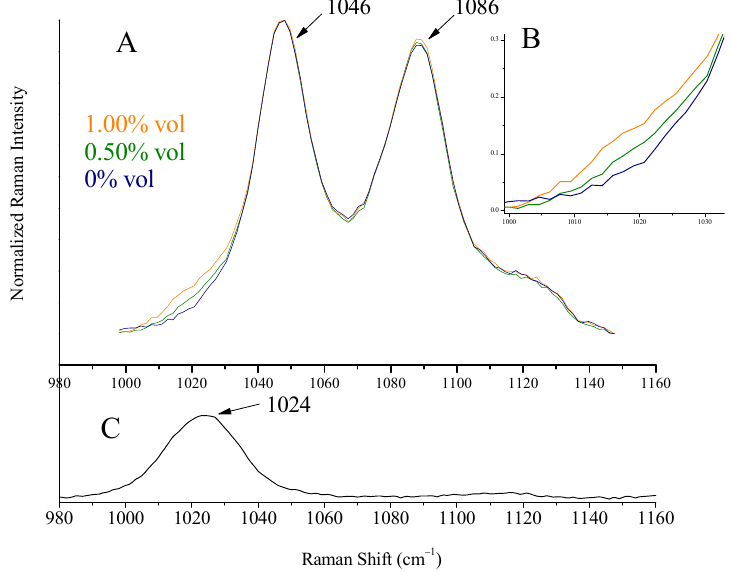
Figure 8. ( A ) Raman spectra of increasing concentrations of methanol (0–1.00% vol) added to Ballantine’s whiskey. The peak of methanol appears as a shoulder on the left of the ethanol peak at 1046 cm −1 . The spectra quoted are normalized to the 1046 cm −1 . ( B ) The magnified spectral area, 1000–1030 cm −1 , of ( A ). Methanol presence can be verified for a content of 0.40% vol or higher. ( C ) Raman spectrum of methanol–water solution (1:1).